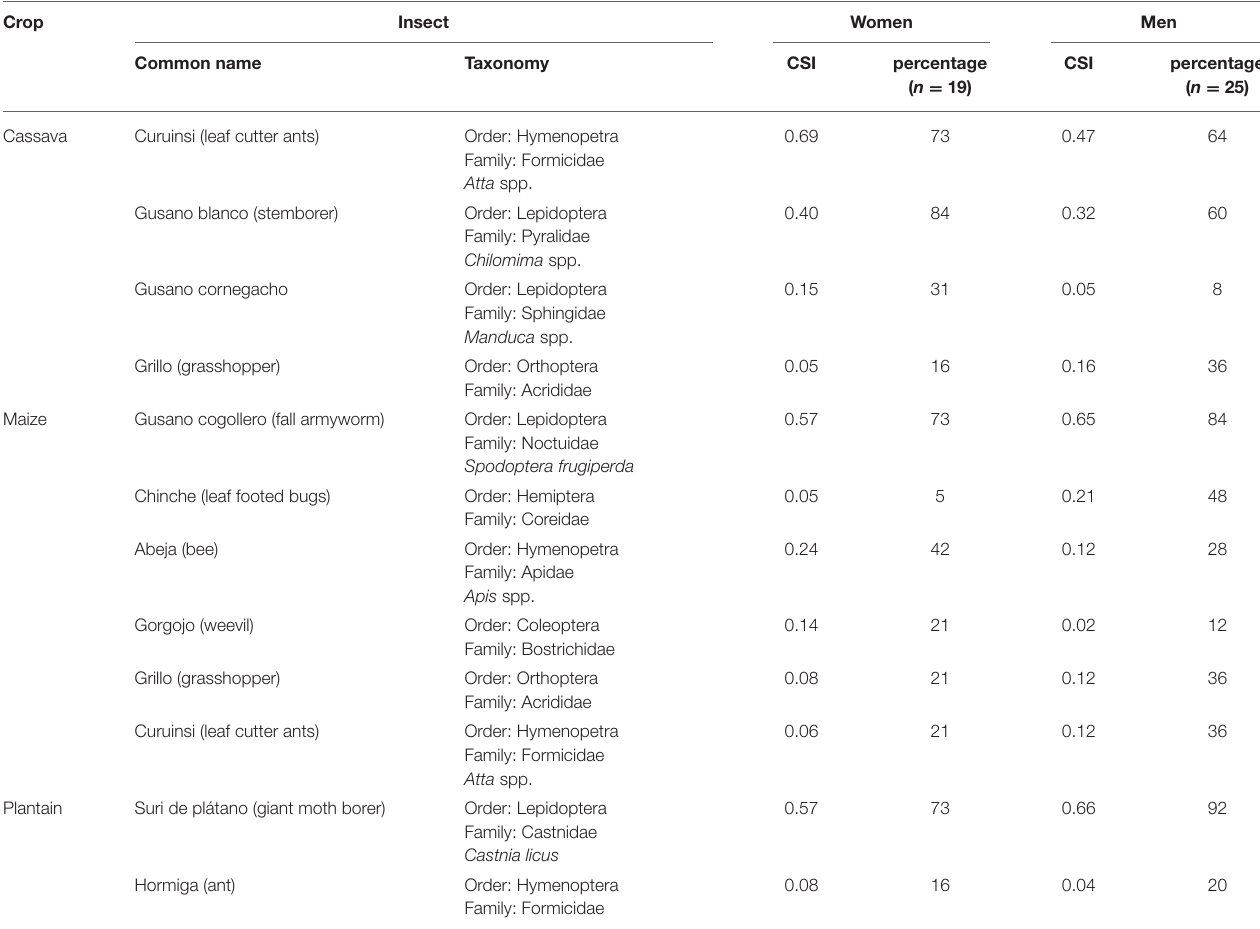
TABLE 2 | Most salient insects associated with cassava, maize, and plantain listed by mestizo women and men, indicating the percentage of women and men that mentioned each insect and their corresponding Sutrop’s cognitive salience index (CSI).